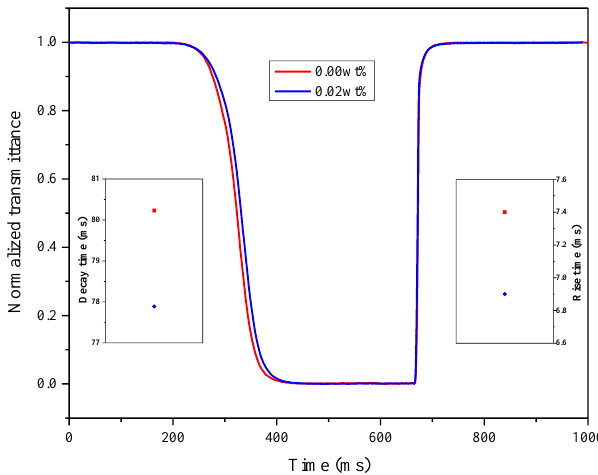
Figure 9. Response time of 0.00 wt% and 0.02 wt% γ -Fe 2 O 3 nanoparticle-doped LC materials.